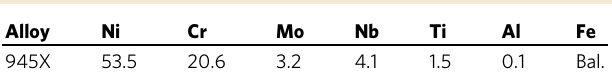
Table 1 Chemical composition of Alloy 945X determined by